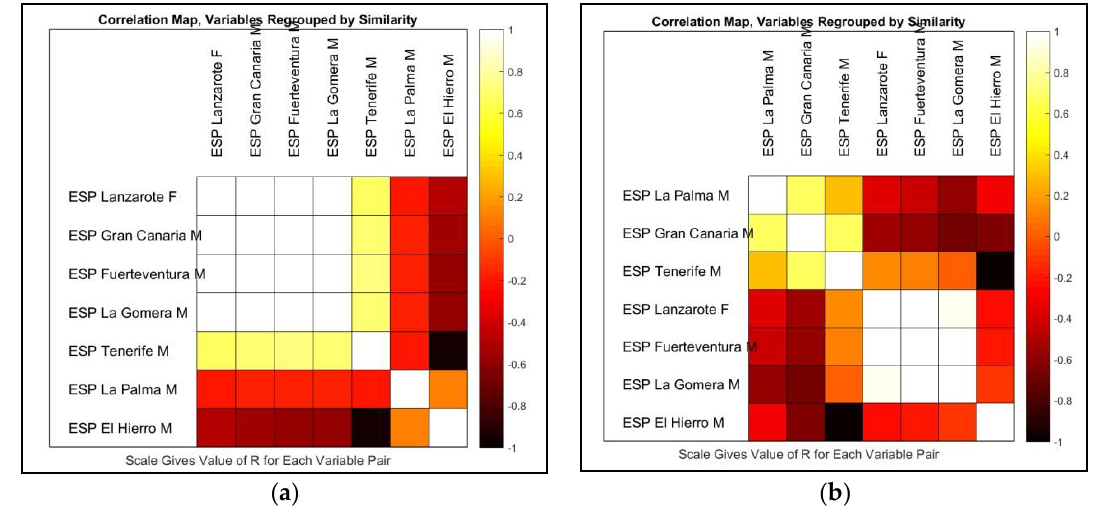
Figure 10. ( a ) Correlation map by survey areas in the simple interrogative sentences; ( b ) Correlation map by survey areas with expansion in the object.